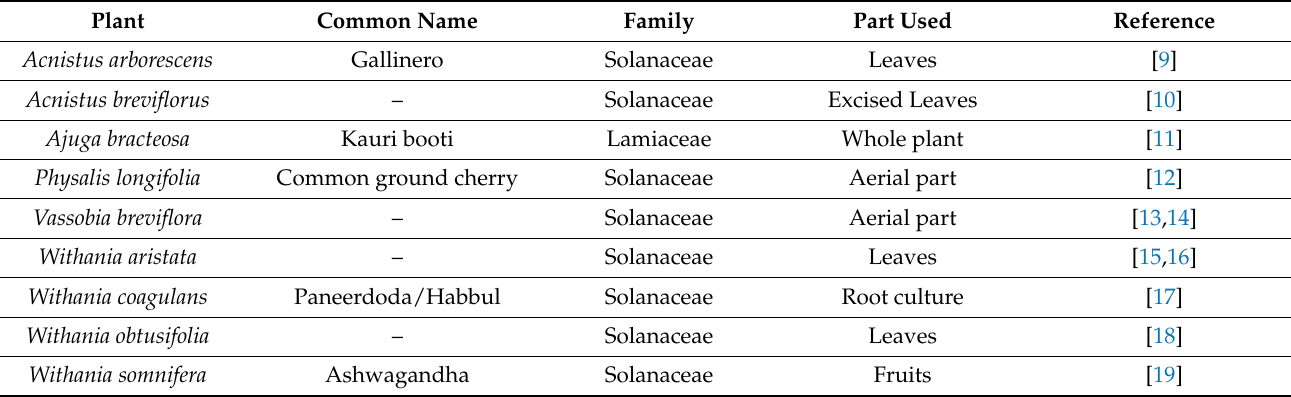
Table 1. Some medicinal plants species containing withaferin